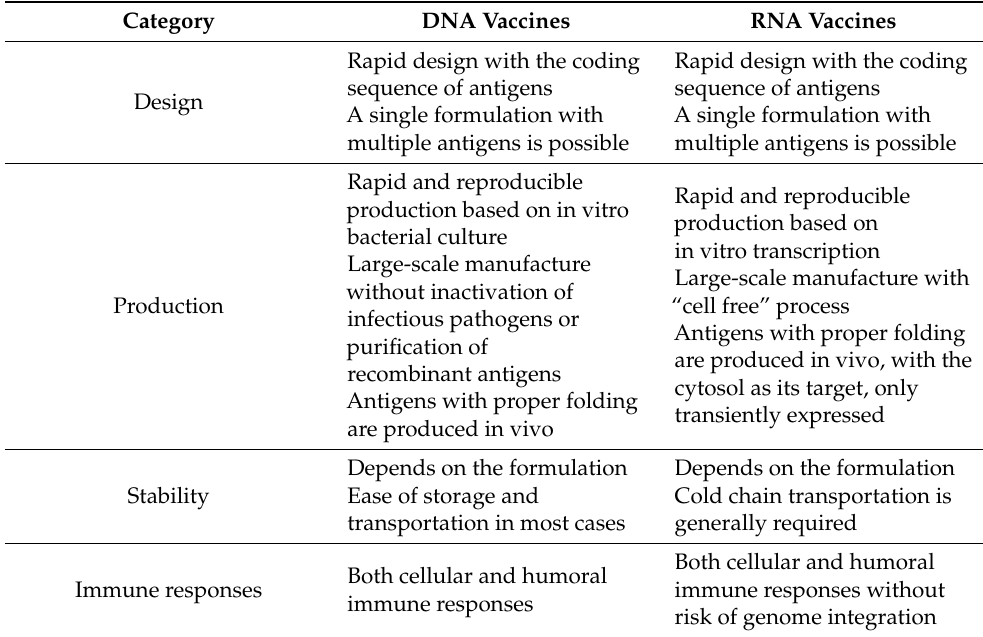
Table 1. Advantages of NA-vaccines compared with conventional